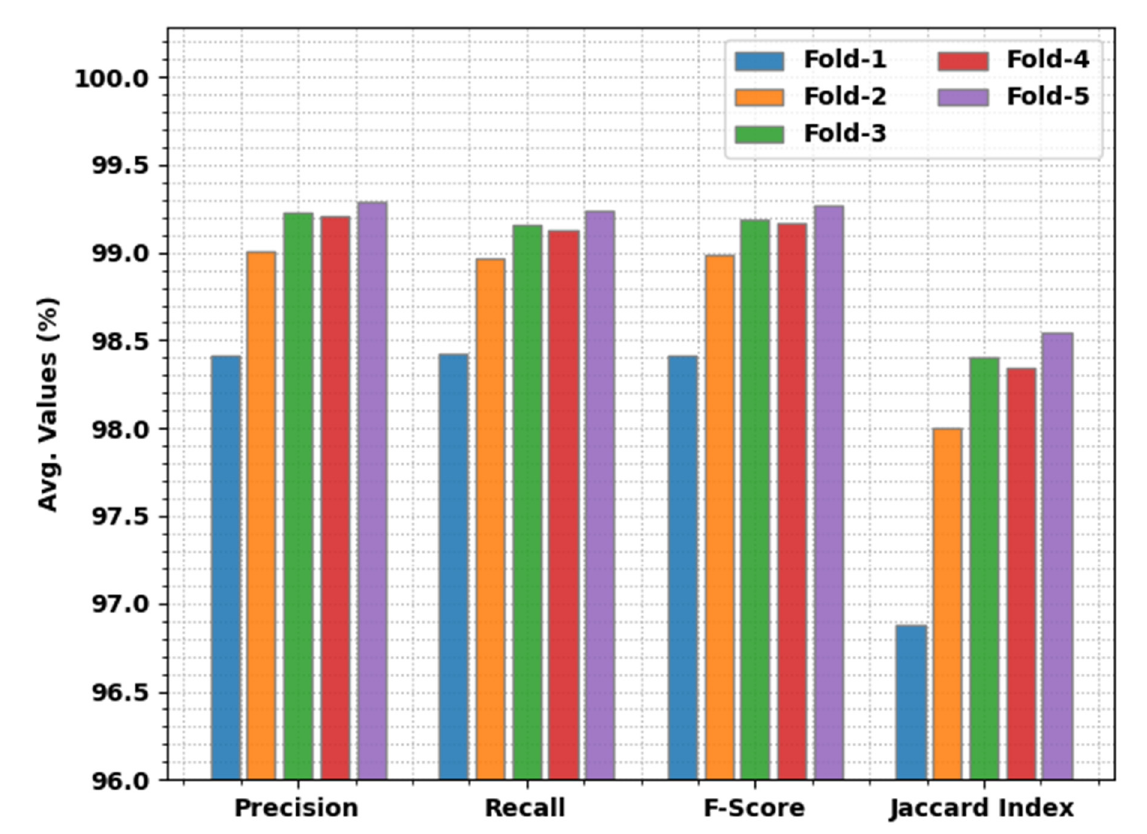
Figure 4. Average analysis of ODAE ‐ WPDC approach with various measures and folds.